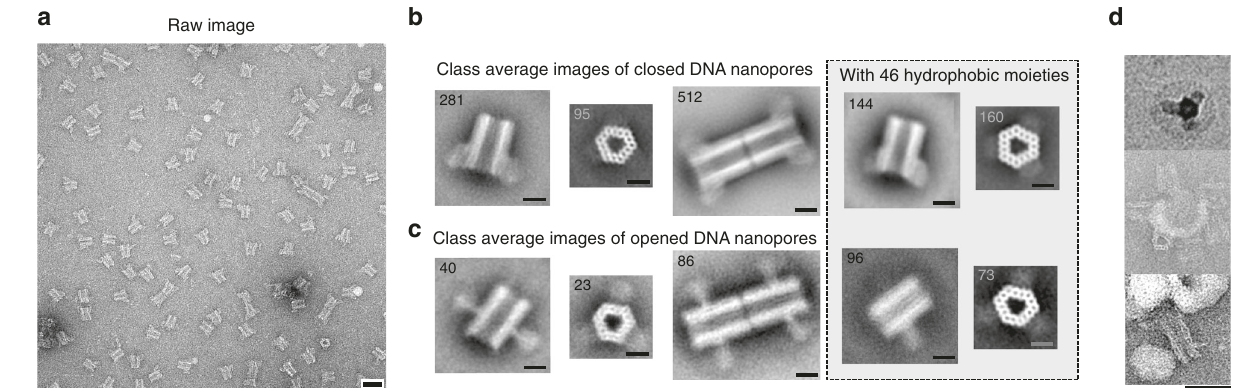
Fig. 2 TEM characterization of the DNA nanopore. a Raw nsTEM image of non-lipidated closed DNA nanopores. b Class-average images of the DNA nanopores in the closed- and c open- fl ap conformations. Grayed box shows closed and open nanopores assembled with 46 LiNA staples in the fl ap- channel system. d Raw TEM image cutouts of lipidated DNA nanopores incubated with liposomes. In the lower image, dimerized DNA nanopores have been formed prior to incubation with SUVs. Scale bars in ( a ) and ( d ) are 50 nm, while the scale bars in ( b ) and ( c ) are 15 nm. Additional raw images